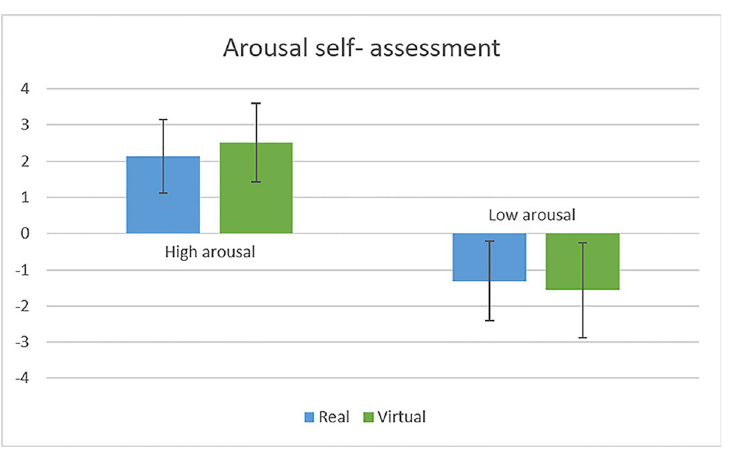
Fig 5. Mean and standard deviations of the self-assessment scores in the real and virtual museums using SAM and a Likert scale (between -4 and +4), in both the high and the low arousal conditions.